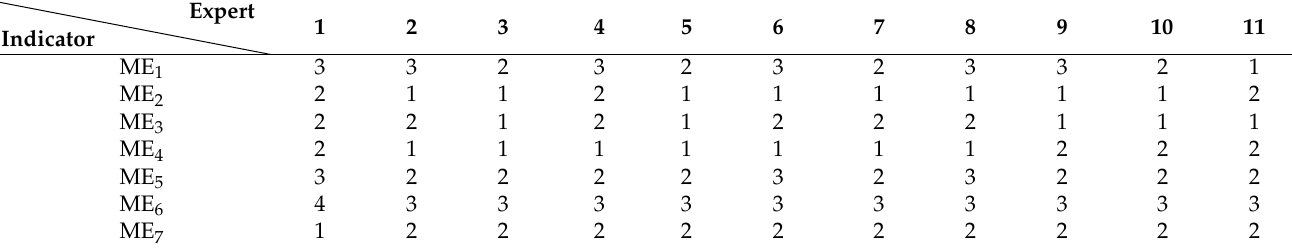
Table A4. Raw data of material and equipment risk (ME).